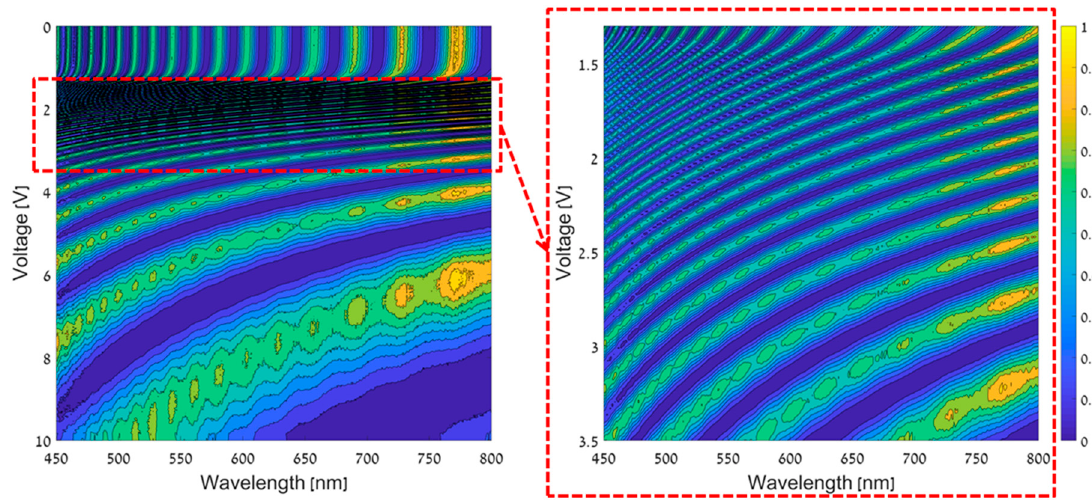
Figure 6. CS-MUSI spectral response map for voltages from 0 V to 10 V ( left map ) and a zoom in on the area where the voltages are from 1.3 V to 3.5 V ( right map